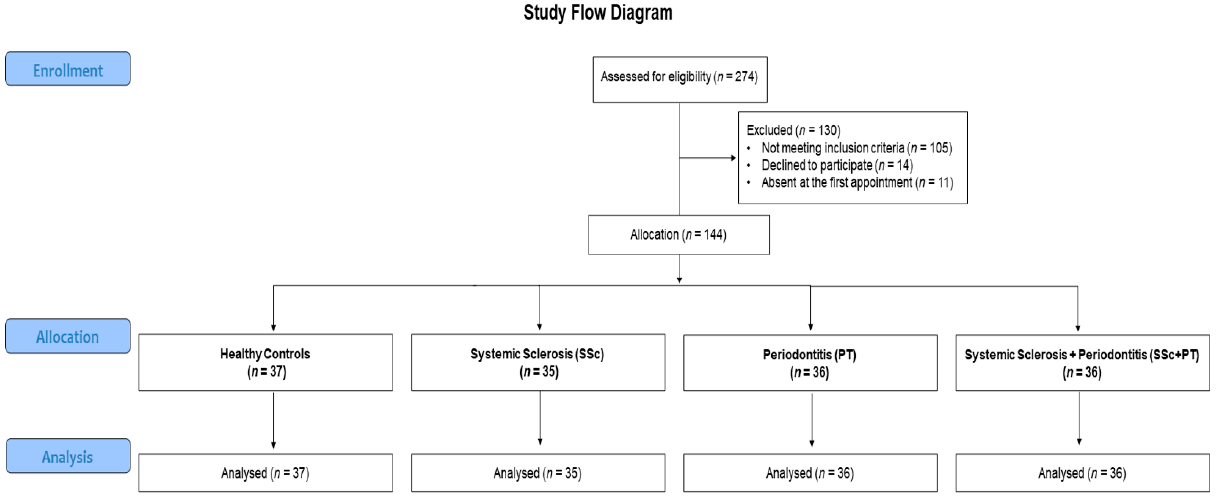
Figure 1. Workflow diagram of the study.